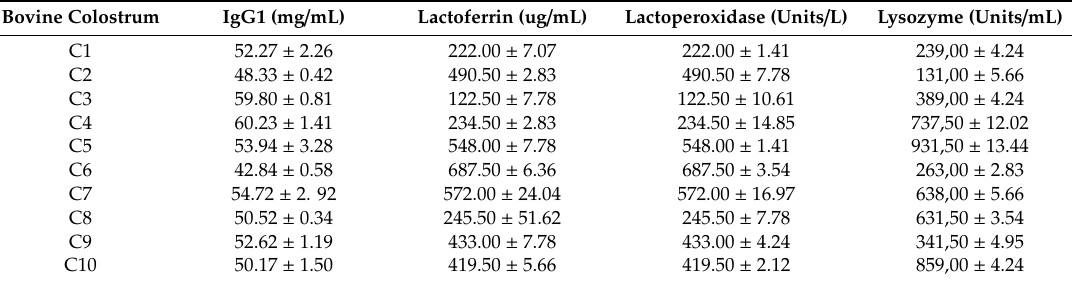
Table 4. Concentration of bioactive compounds in the tested bovine colostrum samples